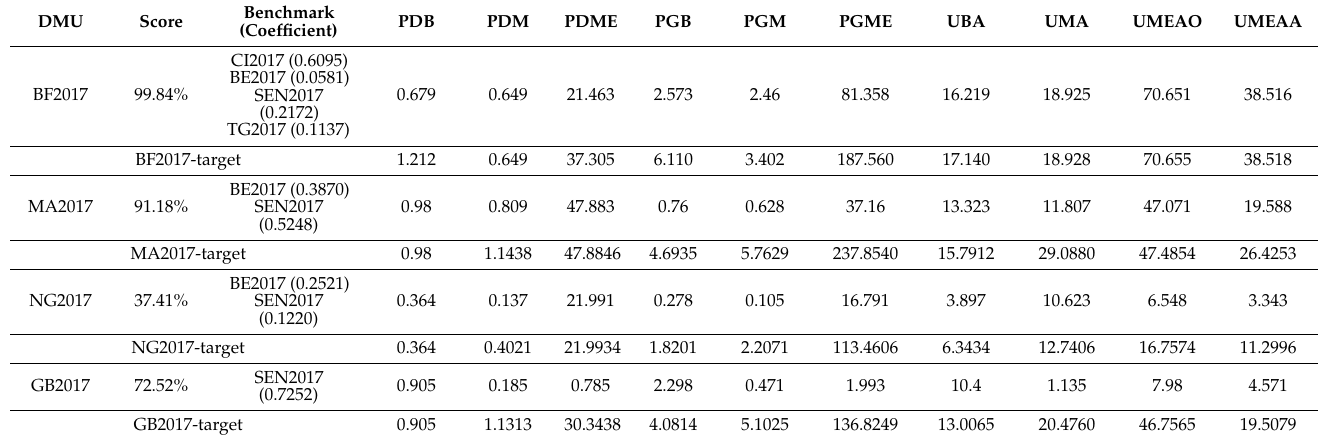
Table 15. Benchmarking—Reference sets for non-efficient countries in